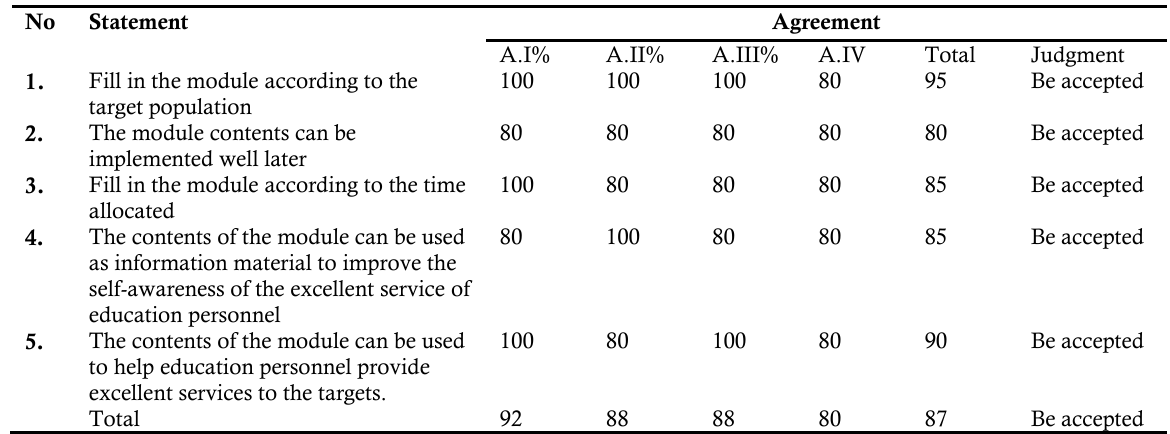
Table 3. Results of The Feasibility Test of Product Content by Experts Based on